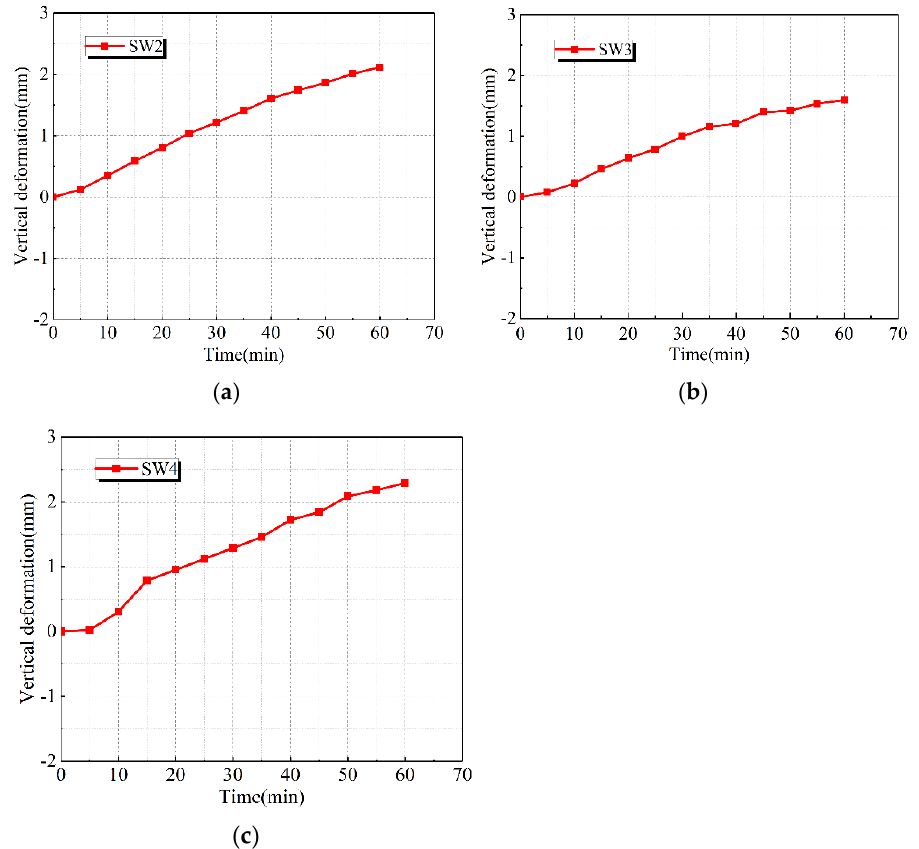
Figure 12. Vertical deformation – time curves of specimens. ( a ) SW2; ( b ) SW3; ( c ) SW4.